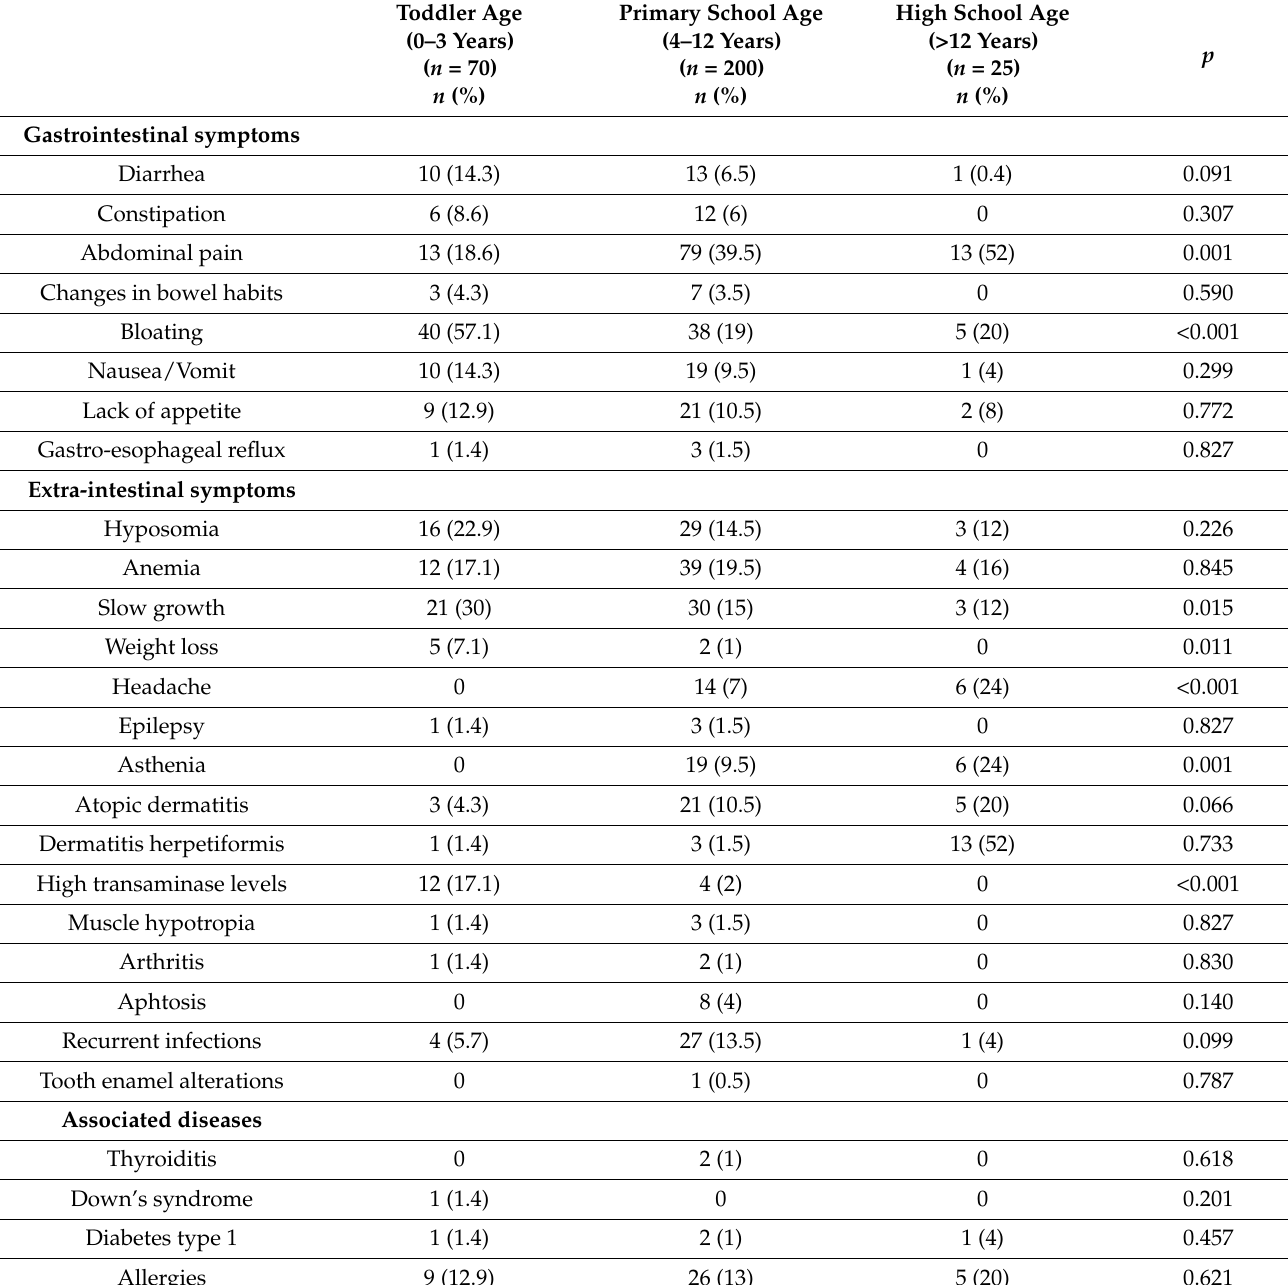
Table 3. Symptom’s pattern and associated diseases of symptomatic CD patients ( n = 295) at different ages as